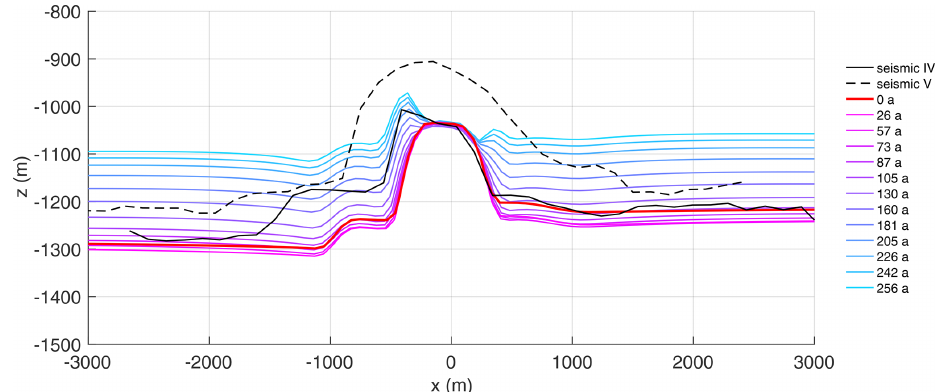
Figure B4. Evolution of the base for the first experiment applying pRES-derived melt rates in the viscoelastic simulation. The black curve shows seismic profile IV (Hofstede et al., 2021b) and the red line the simulated base after the spin-up. For each position of pRES observations, the simulated base is shown using a color distribution ranging from red (furthest upstream) to blue (furthest downstream). The dashed black line is the base of seismic profile V (Hofstede et al., 2021b) near the pRES observation fitting to 130